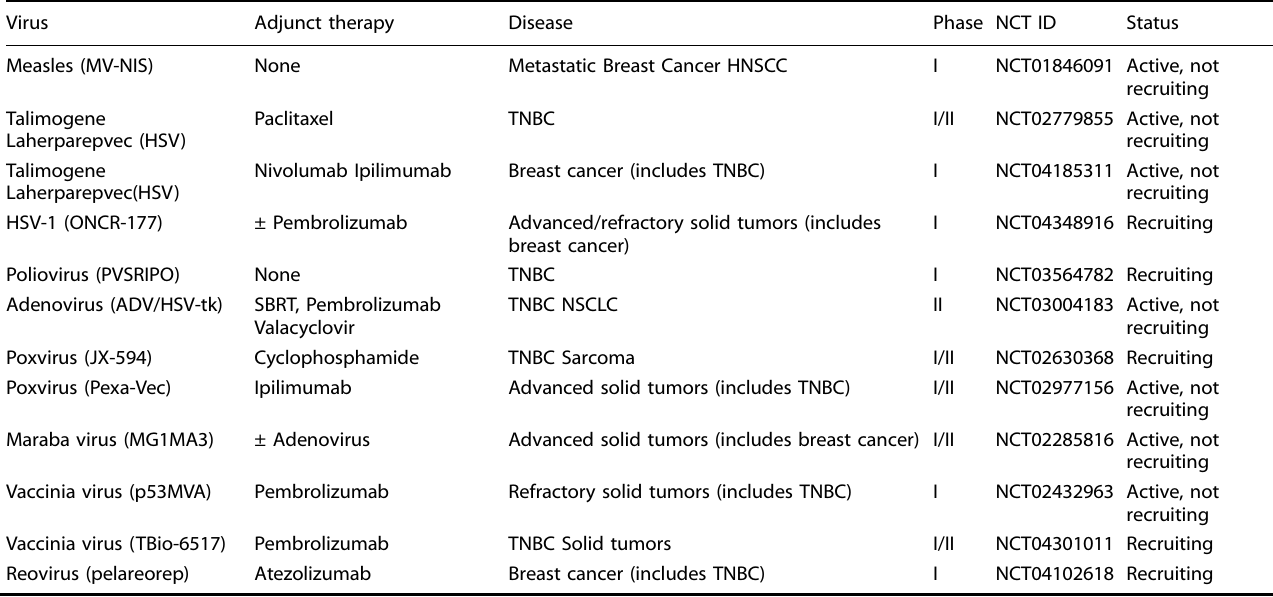
Table 2. Clinical trials for breast cancer treatment using oncolytic virotherapy